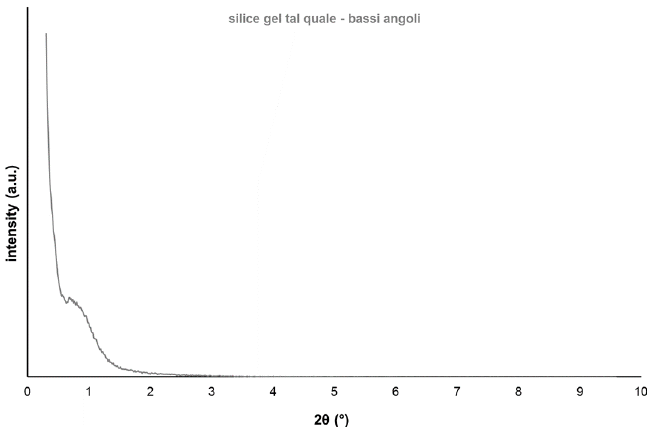
Figure 4. XRD diffraction at small angles for the as-made silica. Figure 4. XRD di ff raction at small angles for the as-made silica.